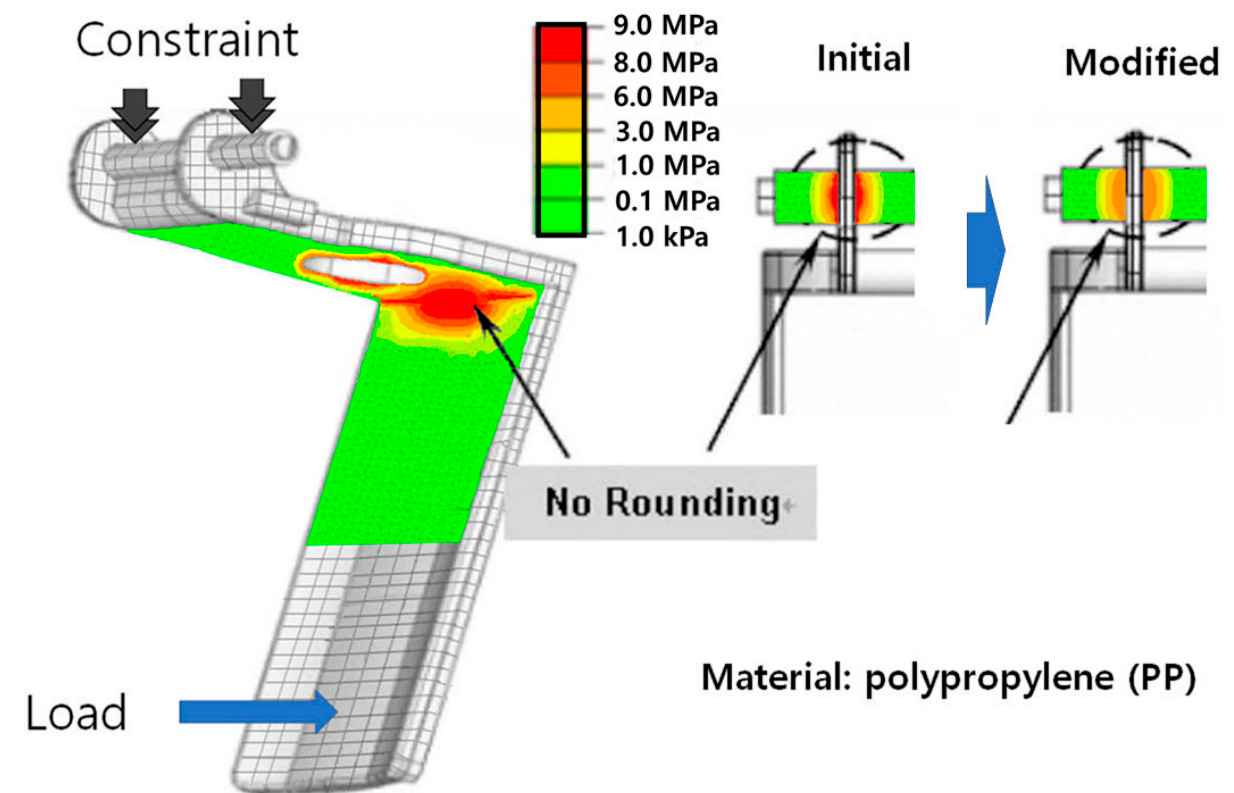
Figure 14. Result of stress analysis by utilizing finite element analysis (FEA).